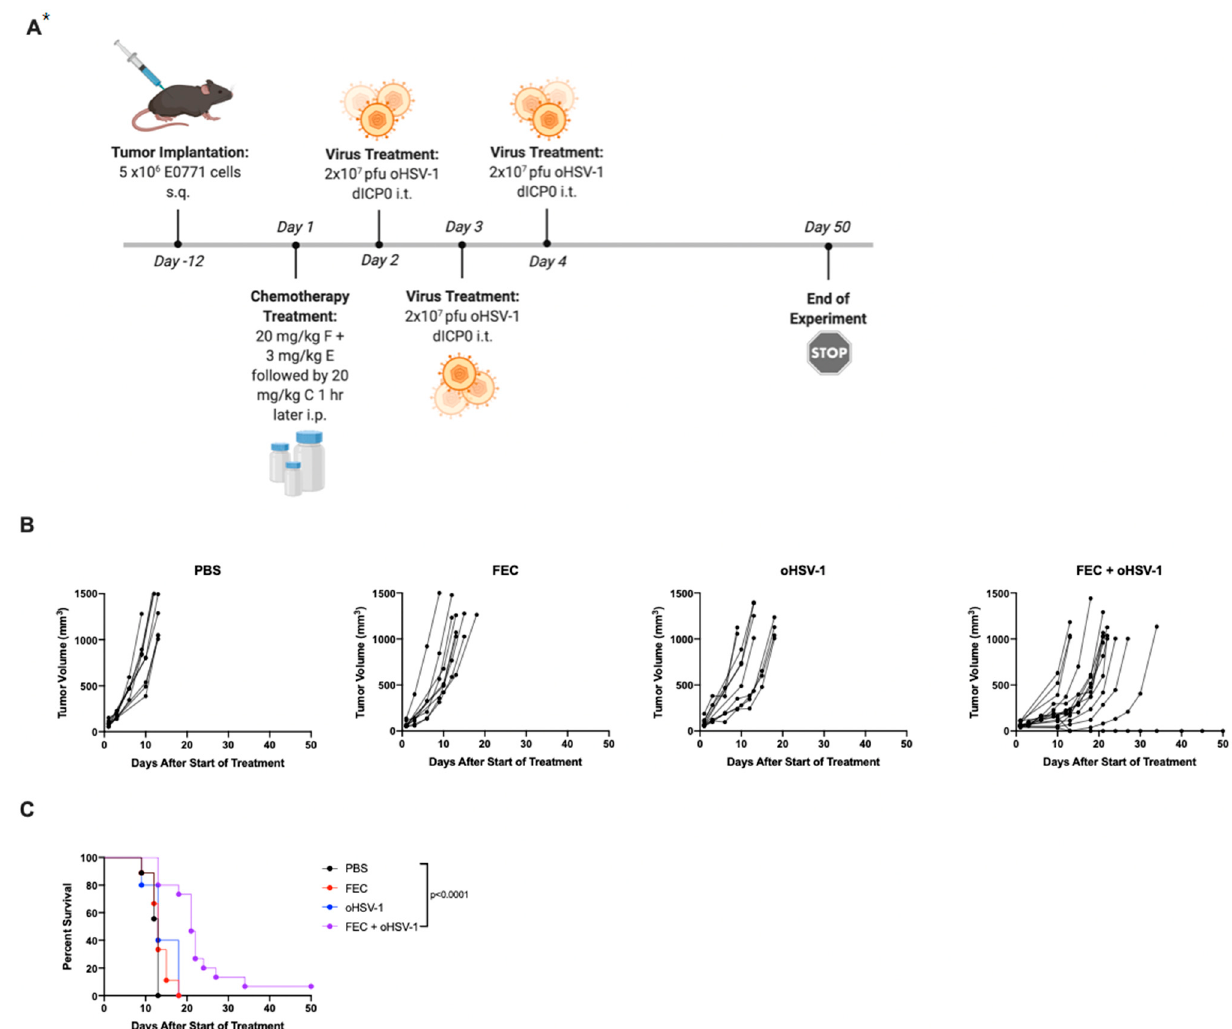
Figure 1. A combination of clinical chemotherapy and oncolytic HSV-1 synergizes for improved disease control in E0771 tumors; ( A ) C57/Bl6 mice bearing E0771 tumors on the left flank were treated with PBS ( n = 9), chemotherapy (FEC, n = 9), oncolytic virus (oHSV-1, n = 9), or chemotherapy + oncolytic virus (FEC + oHSV-1, n = 14). *Created using BioRender.com. ( B ) Tumor volumes were measured every 2–3 days from the start of treatment until mice reached tumor endpoint (volume = 1000 mm 3 ). Each line represents an individual mouse within the group. ( C ) Kaplan–Meier survival curves of each group. *Mantel–Cox test was used for statistical analyses.